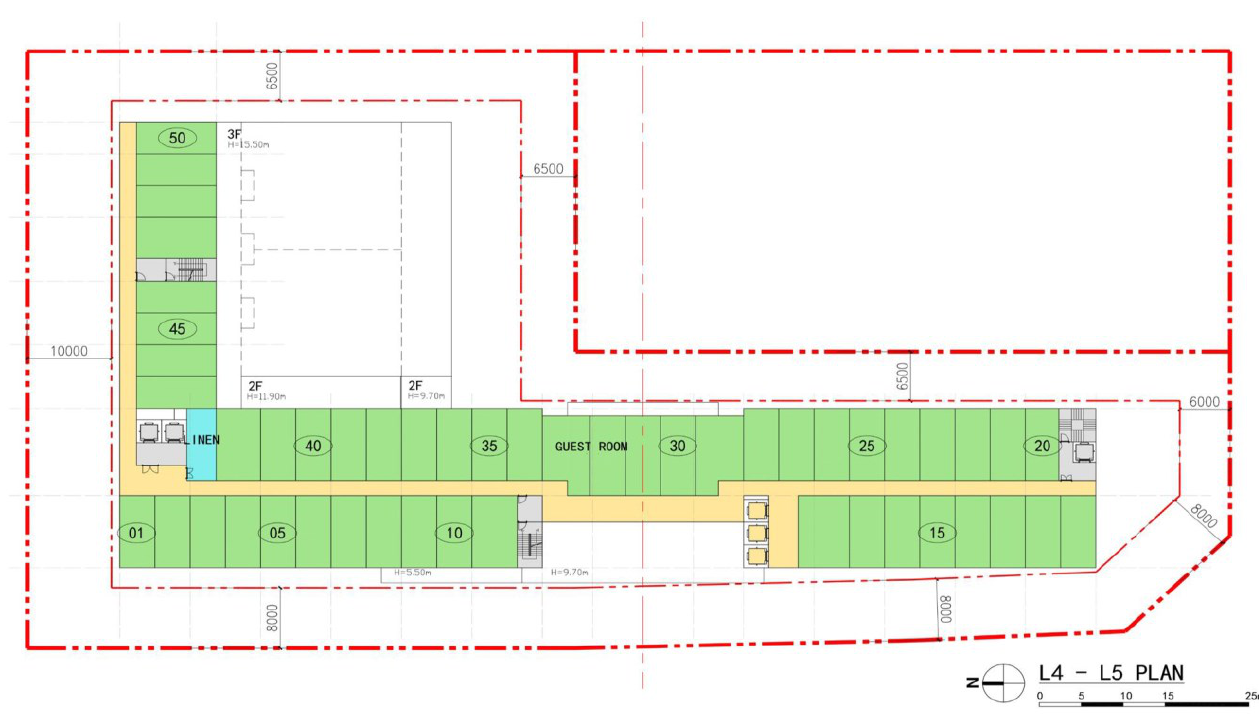
Figure 4. Standard floor plan layout of the object.